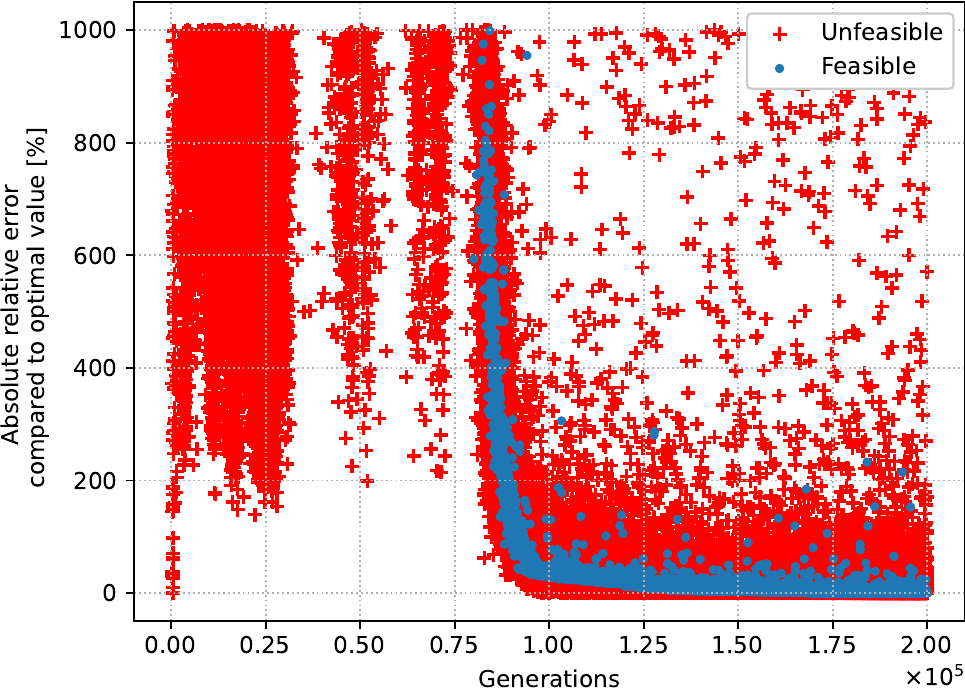
Figure 15. Absolute relative errors compared to the optimal value for successful generations.